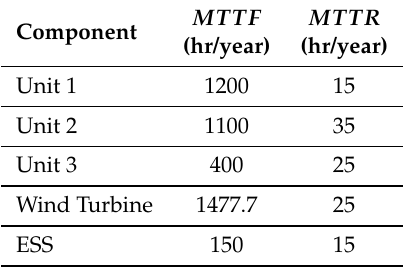
Table 4. Mean time to fail ( MTTF ) and mean time to repair ( MTTR ) of system components.